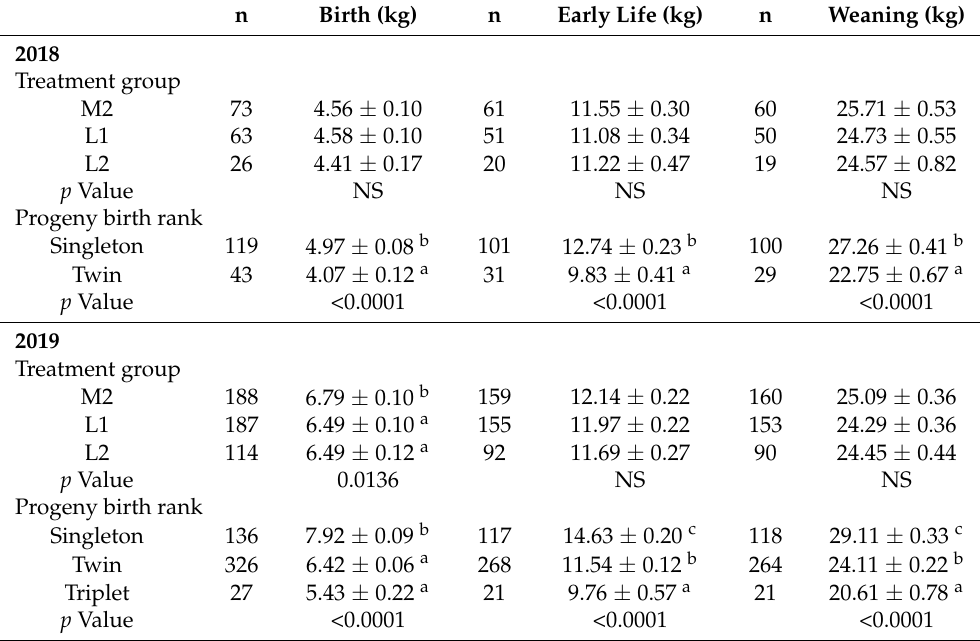
a,b,c Means with different superscripts within columns are significantly different at p < 0.05.